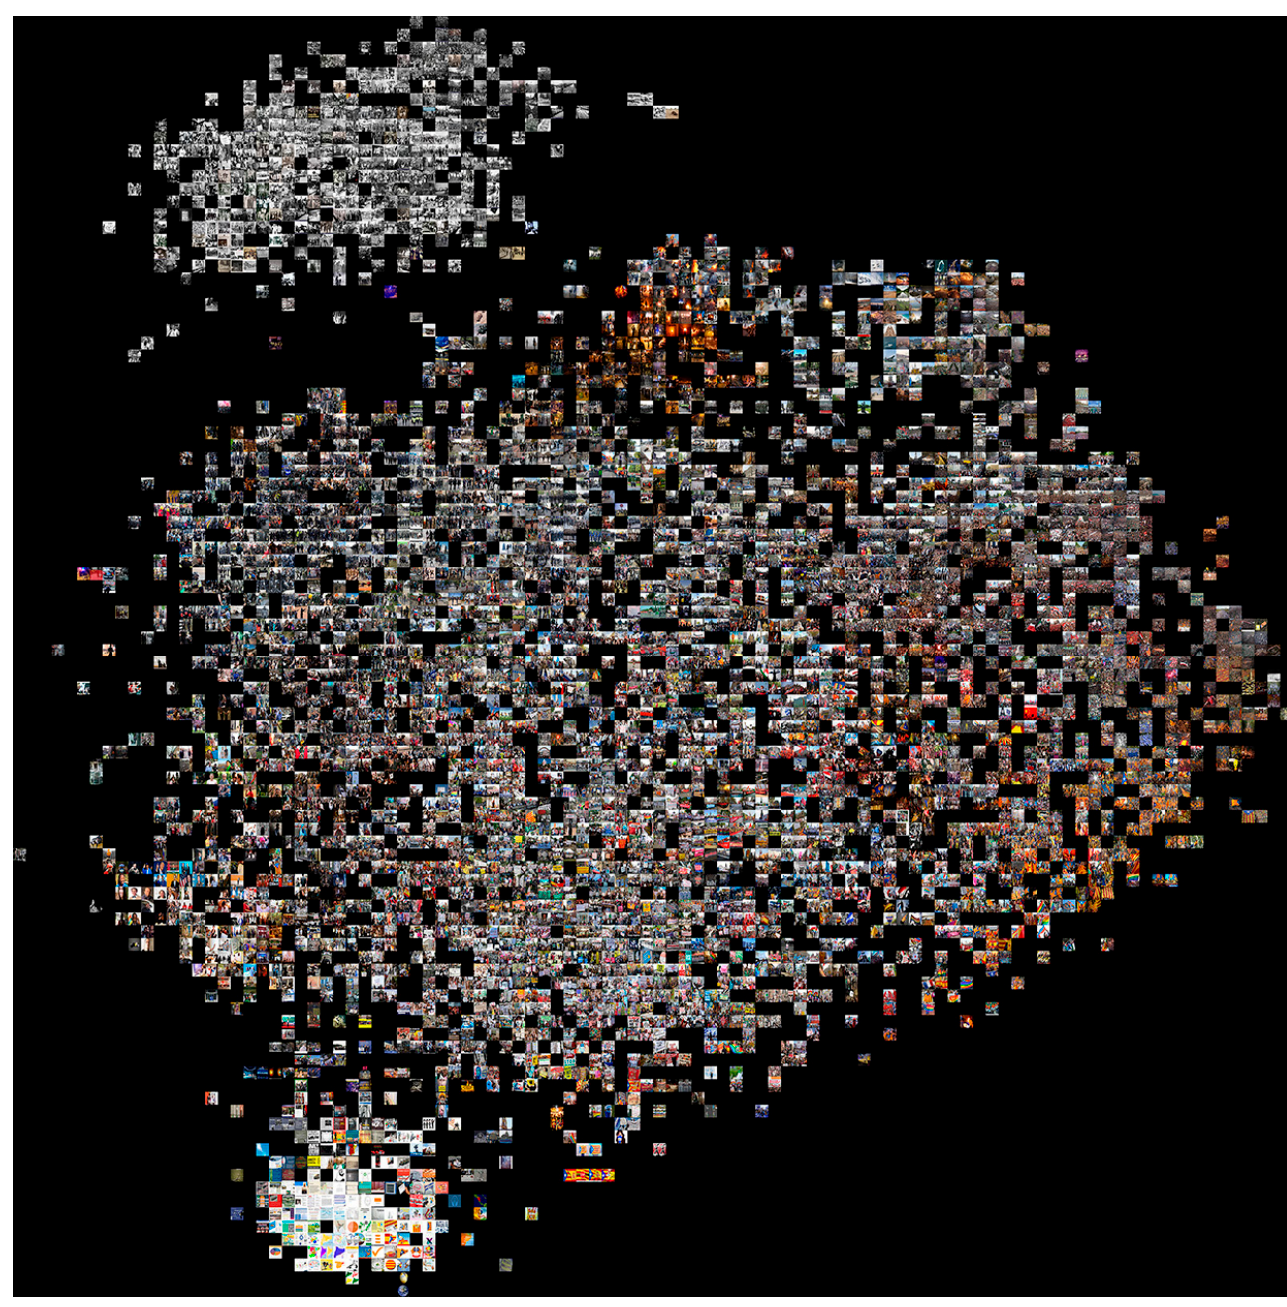
Figure 5. Digital image of 2 × 2 m containing 10,000 images of demonstrations ordered using the artificial network ResNet-50 and the t-SNE algorithm. © Pilar Rosado.